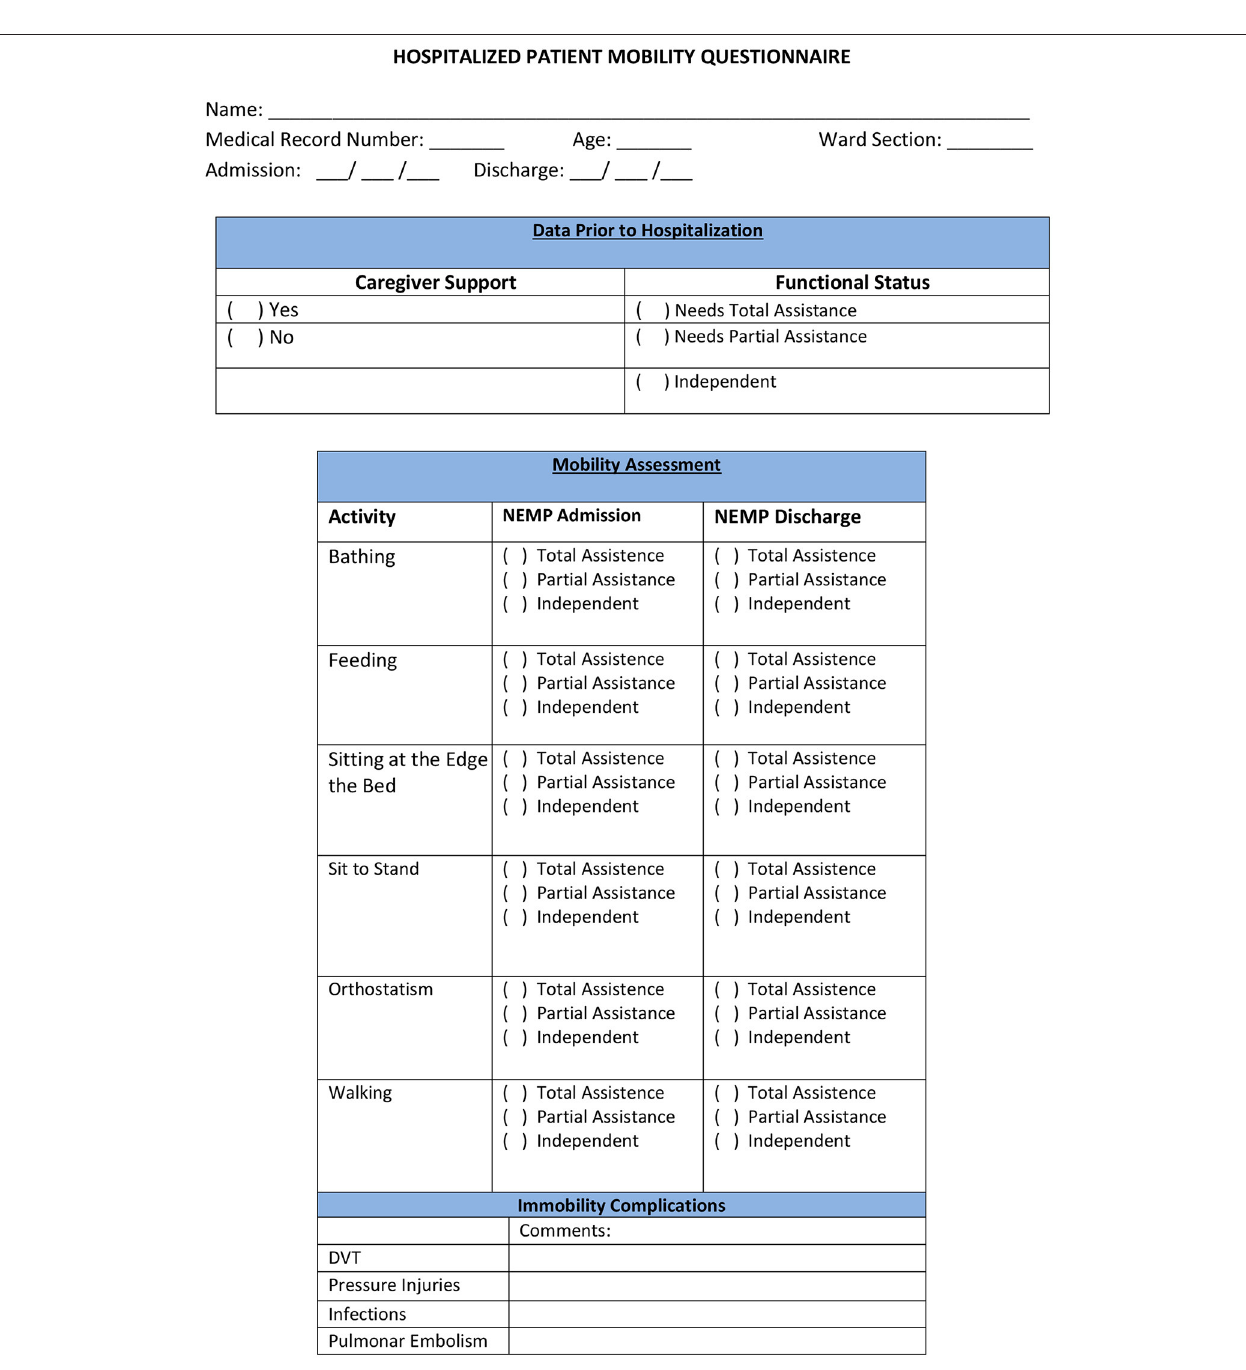
FIGURE 3 | Hospitalized patient mobility